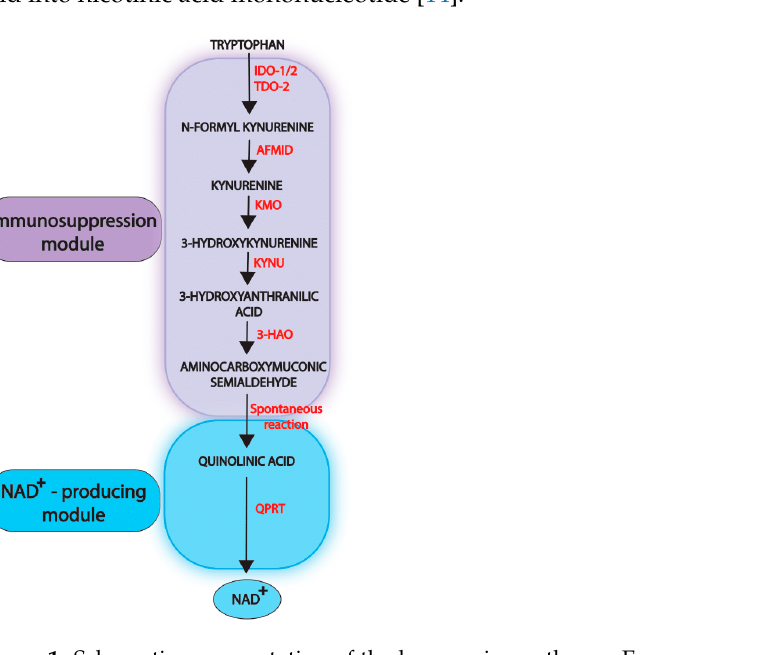
Figure 1. Schematic representation of the kynurenine pathway. Enzymes are written in red. IDO: indoleamine 2-3-dioxygenase, TDO2: Tryptophan 2,3-dioxygenase 2, AFMID: arylformamidase, KYNU: Kynureninase, 3HAO: 3-hydroxyanthranilate 3,4-dioxygenase, QPRT: quinolinate phosphoribosyltransferase. Immunosuppression and NAD + -producing modules are highlighted.